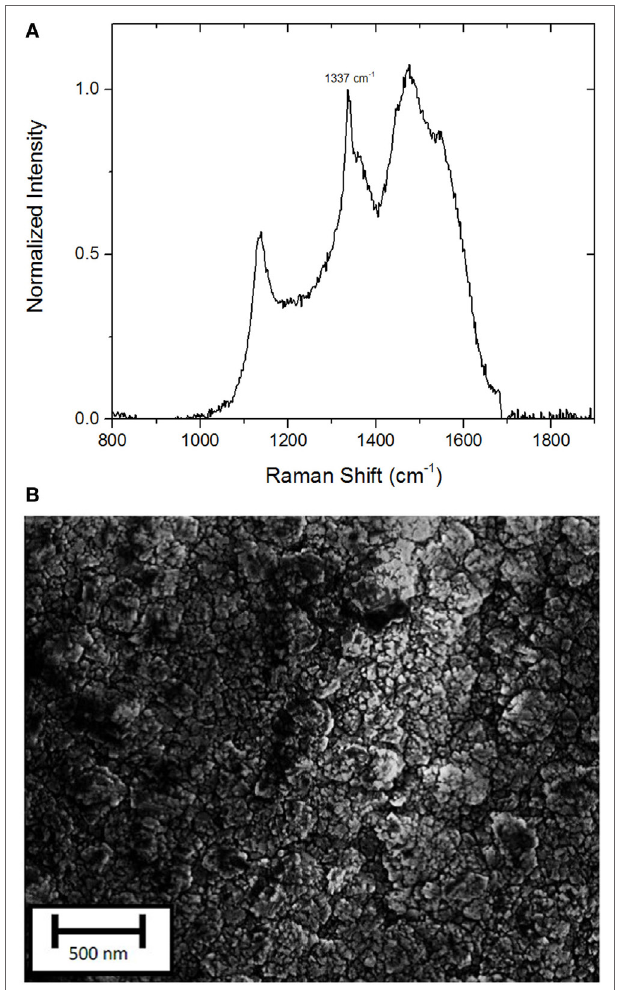
FigUre 3 | An example temporal temperature cycle and emission current profile. This cycle is repeated 20 times for sample set A. Data were taken between 300 and 600 °C set-point temperature. The behavior at higher set-point temperatures is qualitatively similar to that shown here.